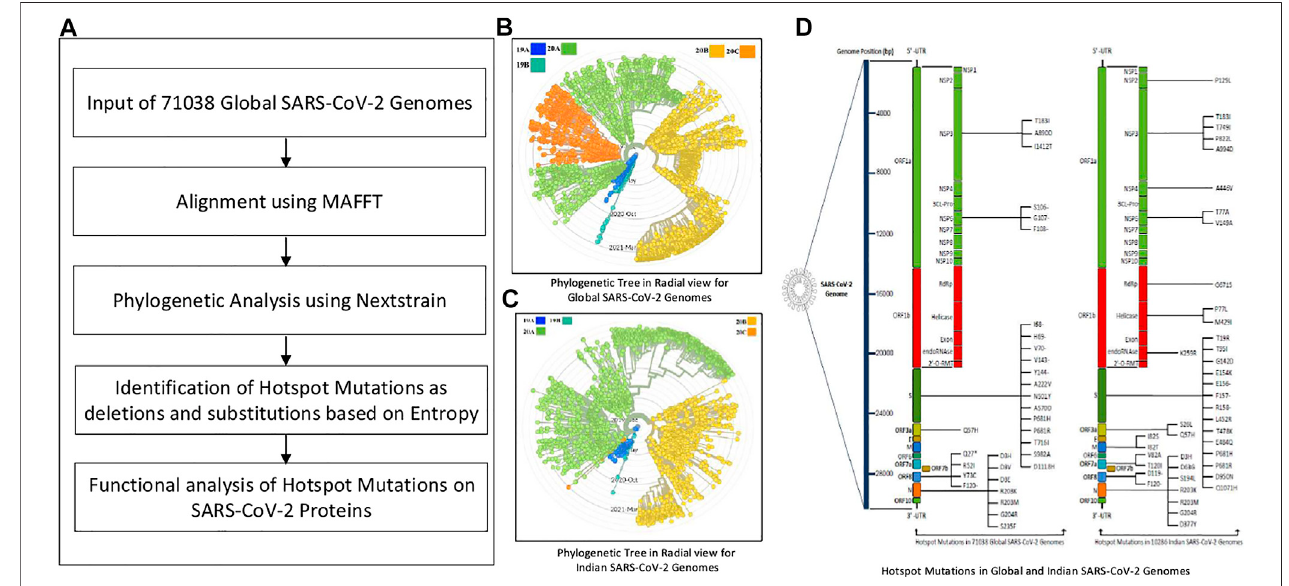
FIGURE 1 | Pipeline of the work fl